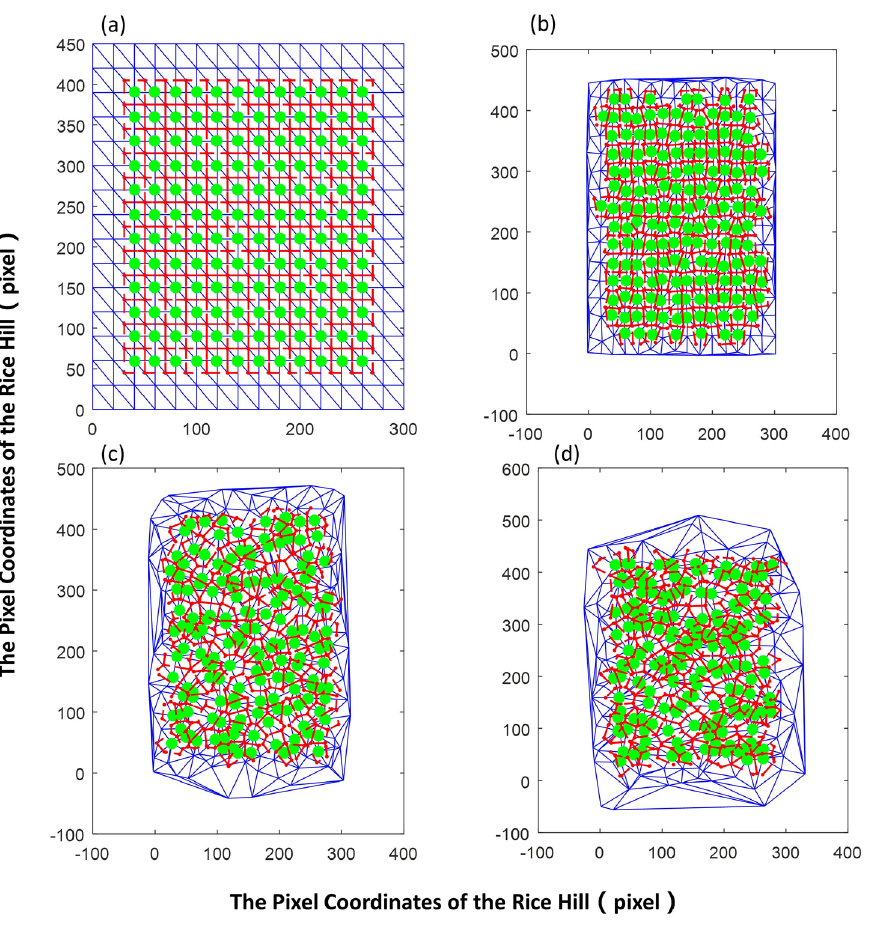
Figure 5. Distribution of the rice clusters randomly simulated at different variance levels of random perturbation and the region occupied by the rice clusters. Subfigures ( a – d ) show σ = 0RD, 0.1RD, 0.6RD, and RD, respectively. Large dot, the position of the rice cluster; red dot, the outer center of the triangle; blue dotted line, the triangular segmentation result; red solid line, the boundary line of the region occupied by the rice